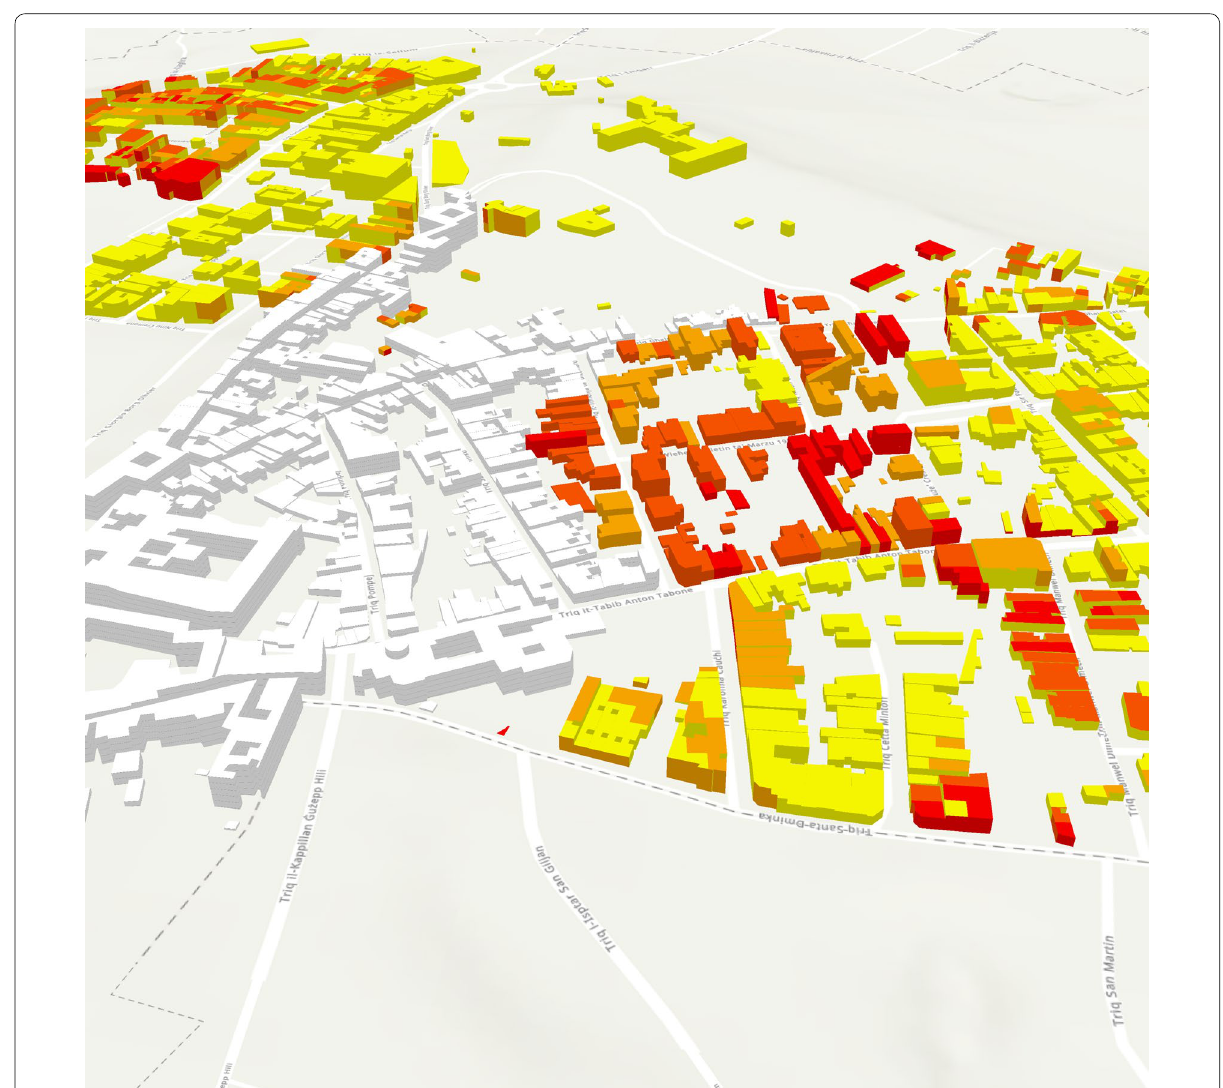
Fig. 14 Extract from the results of the visibility analyses carried out on the current state of the built-up south-eastern area of